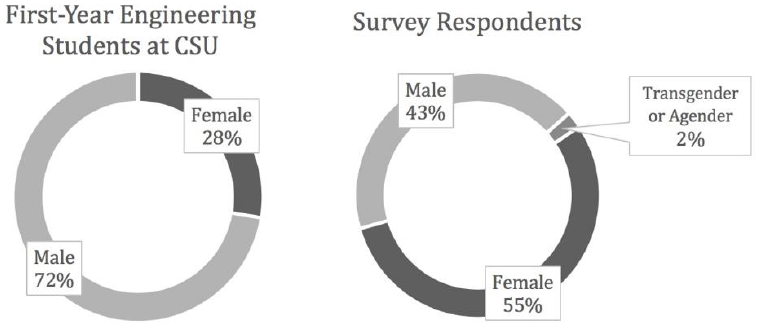
Fig. 1. First-year engineering students and survey respondents